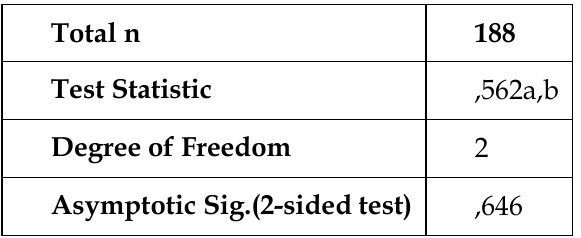
Table 7. Concern about breaching privacy and ethnicity. Kruskal-Wallis sig. test. The test statistic is adjusted for ties.